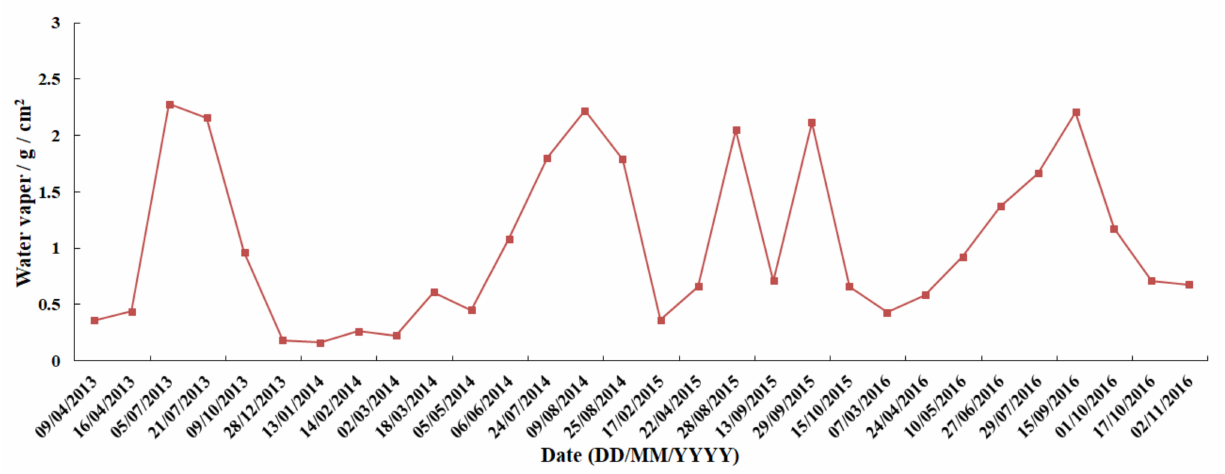
Figure 10. Atmospheric water vapor content in the study